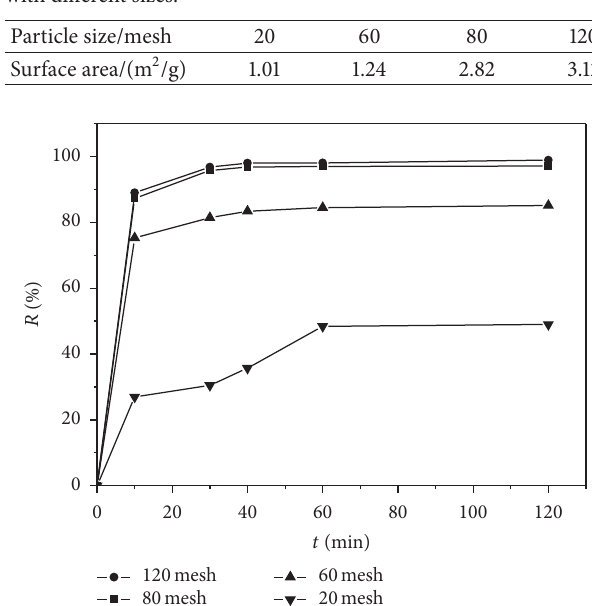
Figure 2: The effect of particle sizes on the adsorption of MB on WS. Conditions: temperature (298K), MB concentration (20 mg/L), and WS adsorbent dosage (1.25 g/L).